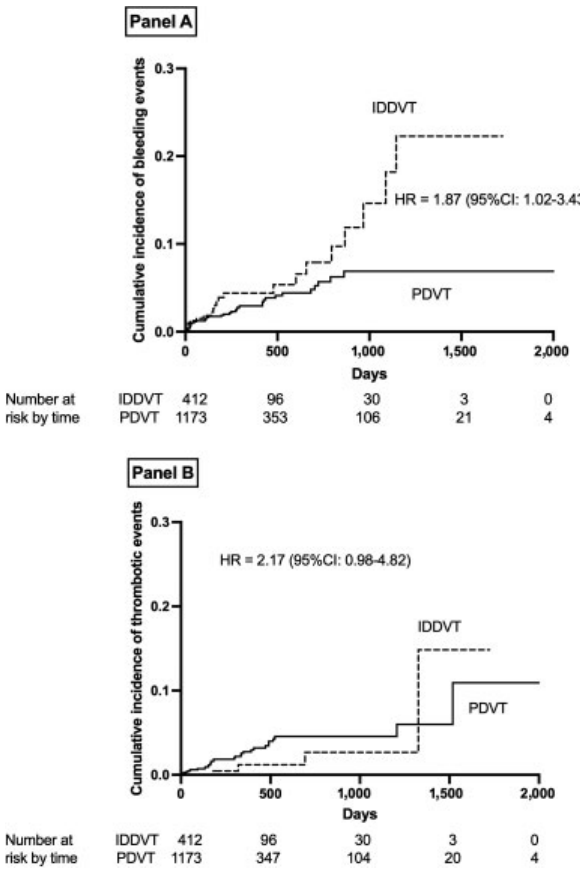
Fig. 2 Cumulativeoccurrenceofbleeding( PanelA )andthrombotic( Panel B ) events in patients with isolated distal (IDDVT) or proximal (PDVT) deep vein thrombosis. CI, con fi dence interval; HR, hazard